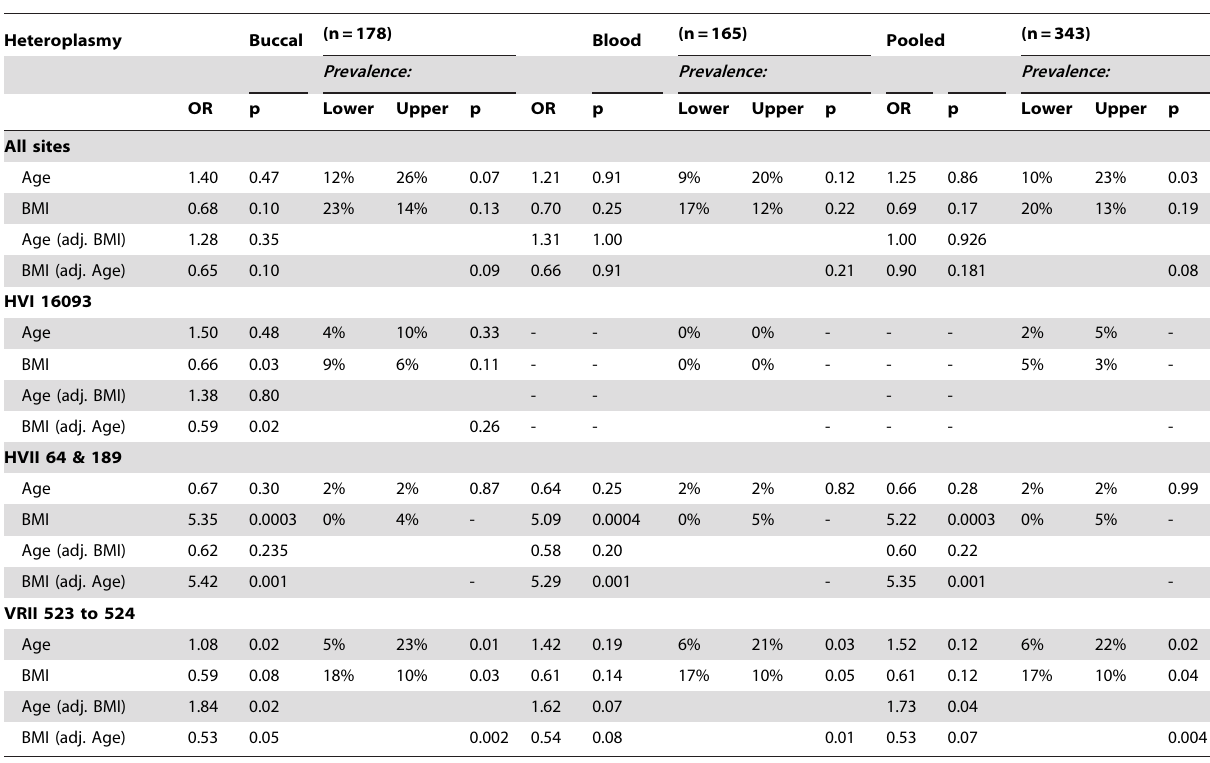
Table 3. Heteroplasmic association with age and body mass index (BMI).